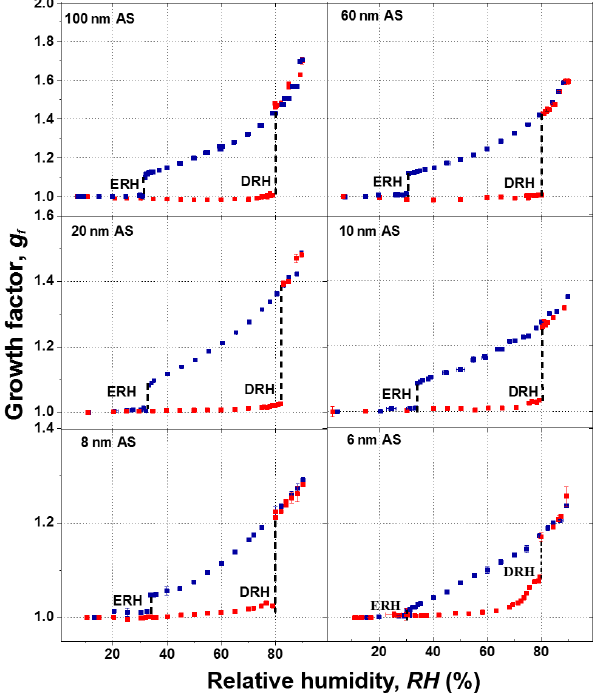
Figure 7. Mobility diameter hygroscopic growth factors ( g f ) of am- monium sulfate (AS) aerosol nanoparticles with a dry mobility di- ameter from 6 to 100nm in the deliquescence mode (red square and error bar) and the efflorescence mode (royal blue square and error bar). Deliquescence and efflorescence relative humidity (DRH and ERH; black dashed line) of ammonium sulfate (AS) nanoparticles with dry mobility diameter from 6 to 100nm.